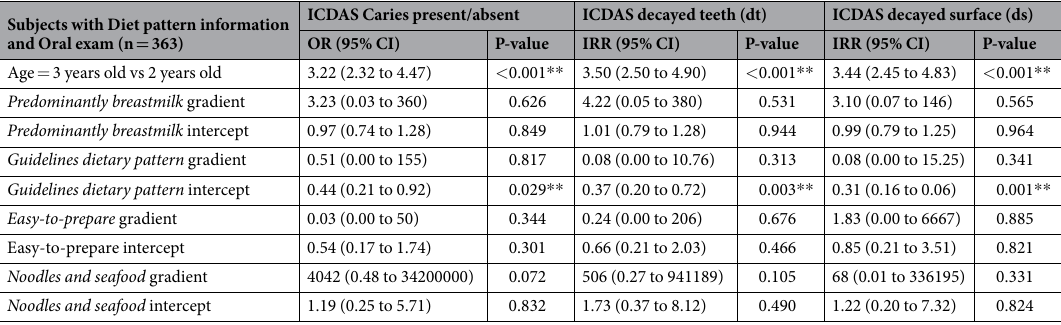
Table 3. Association of dietary pattern trajectories with the 3 different methods of coding Early Childhood Caries before